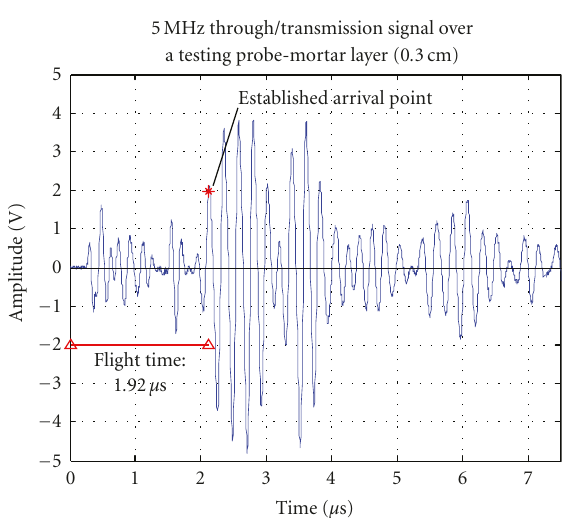
Figure 2: A-scan corresponding to the estimation of the delay in 0.3 cm mortar thickness.